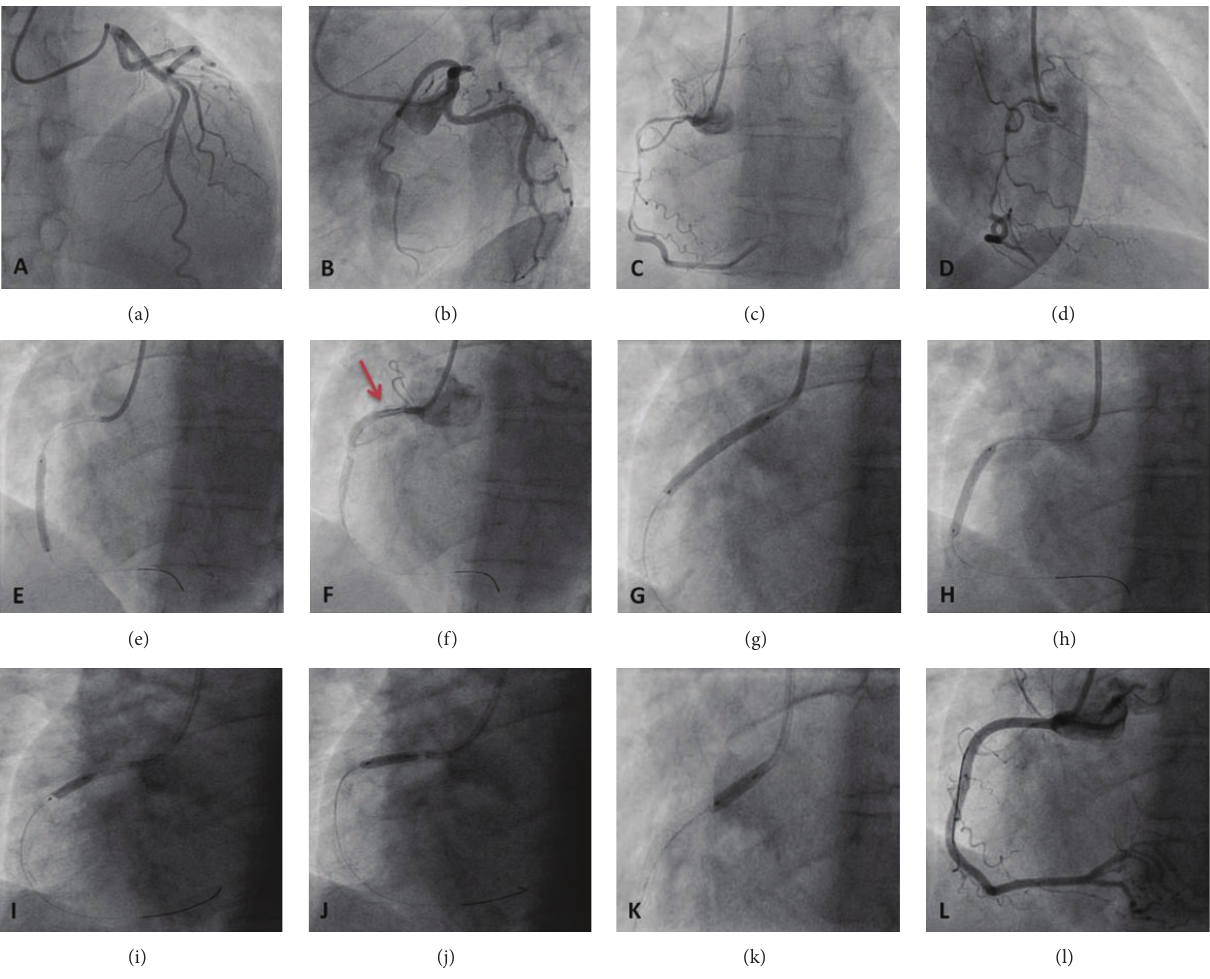
Figure2:(a,b)RAOcranialandspiderprojectionsshowingnormalleft coronarysystem.(c,d)LAOandRAOprojectionsshowingaverylong tubular stenosis of the RCA, with abrupt demarcation from normal distal segments, which did not respond to intracoronary nitroglycerine and balloon predilation. (e) After the implantation of the first ZES 2.75/30 mm, there was a propagation of the dissection flap proximally (white line; red arrow (f)), successfully sealed with a second ZES 3/30 mm implanted proximally (g). (h) Postdilation with the stent balloon at the overlap of the 2 stents and with noncompliant balloon 3.25 mm proximally at 16atm (i–k) with an excellent final angiographic result